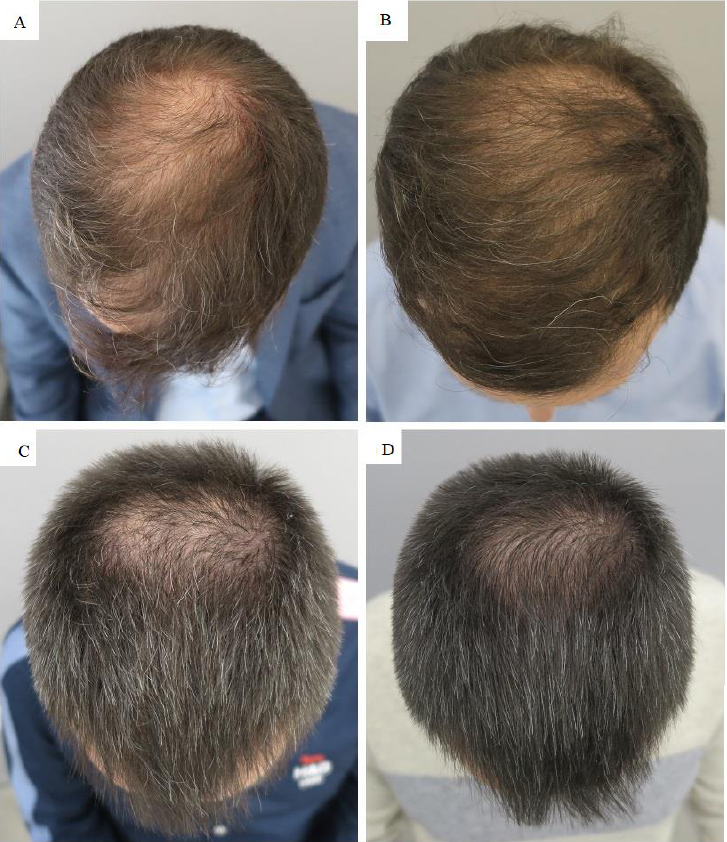
Figure 1. Results of autologous platelet-rich plasma (PRP) treatment in patients with androgenetic alopecia: patient 1 and 2 before ( A , C ) and six months after ( B , D ) treatment. Further detailed analysis was performed using the TrichoLAB AI-powered software.